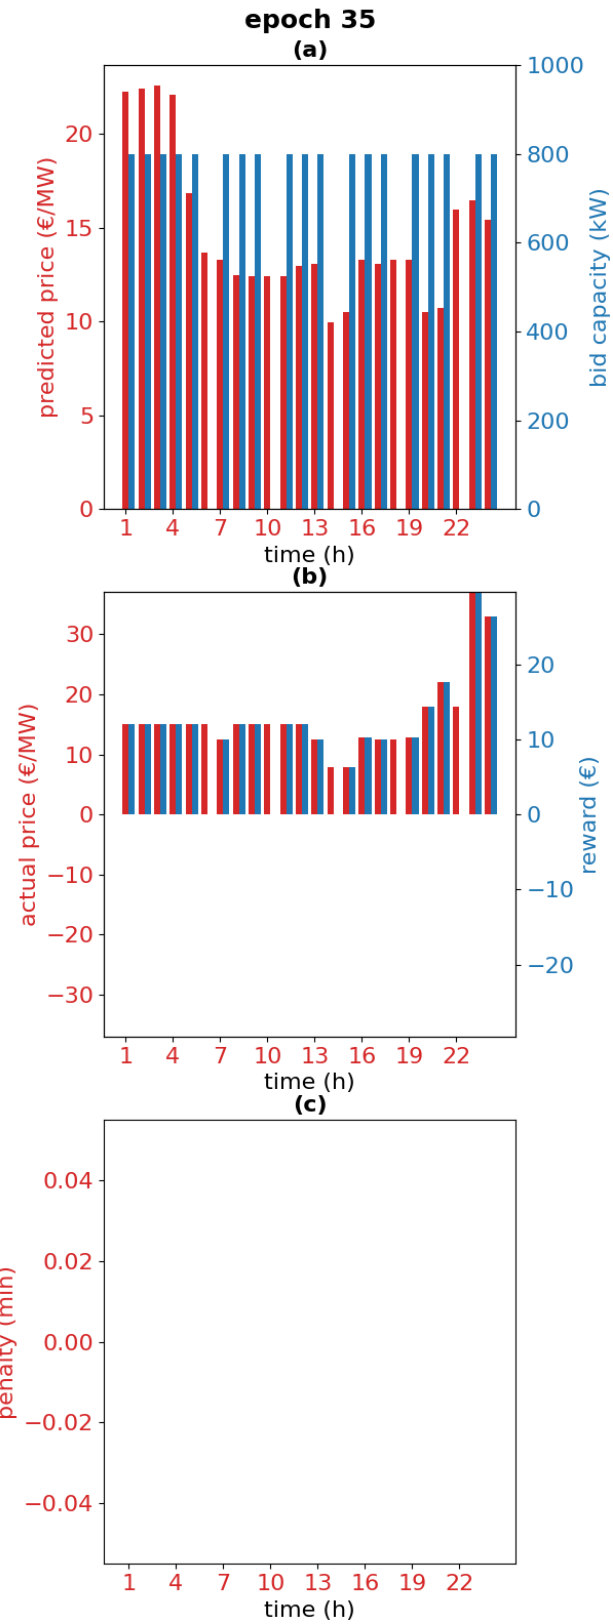
Figure 11. Bids and predicted price ( a ), reward and actual market price ( b ) and penalties ( c ) for the